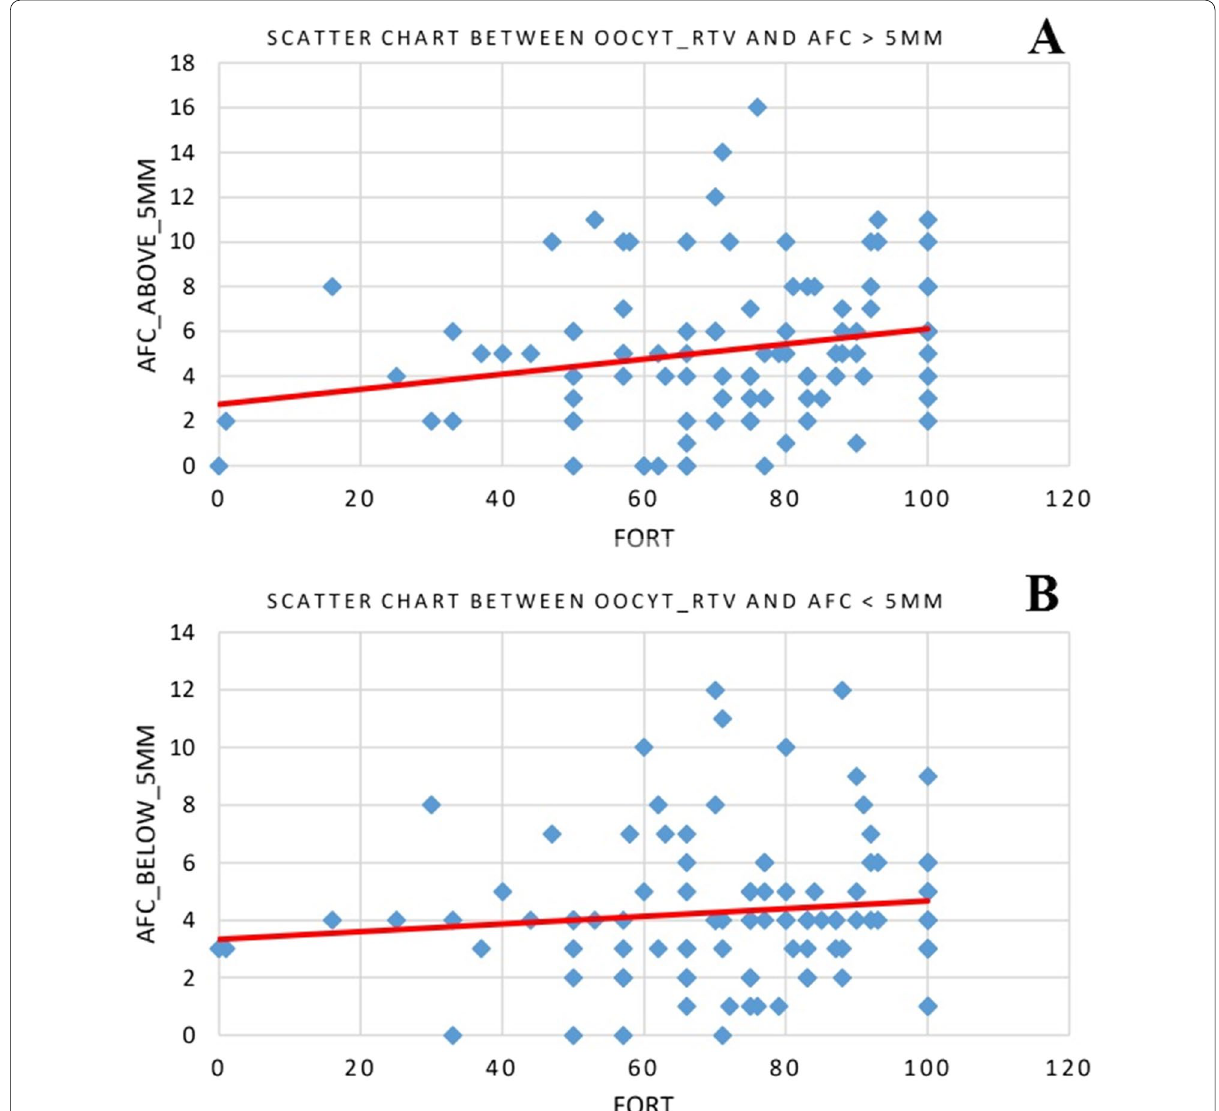
Fig. 1 Scatter chart between FORT (Follicular Output Rate) and AFC (antral follicle count) > 5 ( A ) and AFC (antral follicle count)